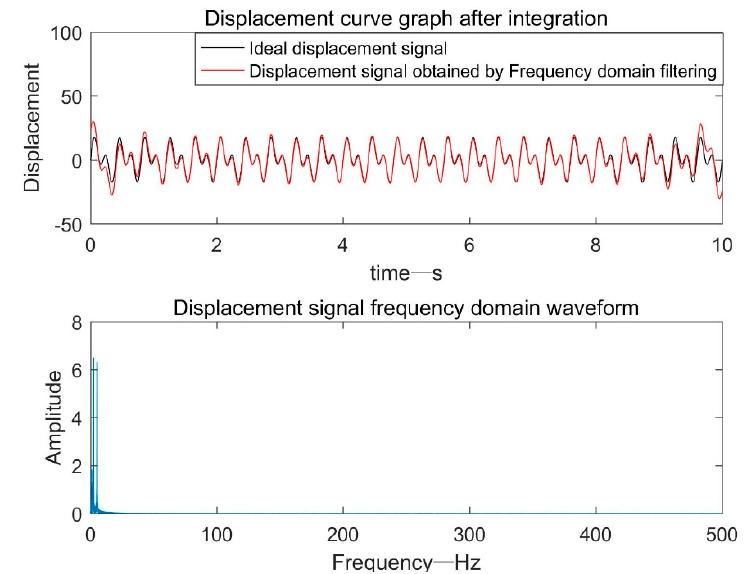
Figure 3. Displacement signal after frequency domain filtering.